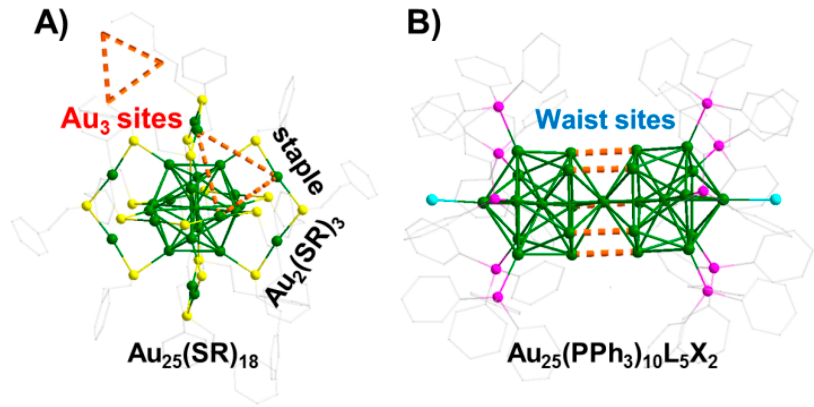
Figure 3. Framework of Au 25 (SR) 18 ( A ) and Au 25 (PPh 3 ) 10 L 5 Cl 2 ( B ). The orange areas in are the Au 3 and the waist active sites during the catalysis. Reproduced with permission from [36]. American Chemical Society, 2008 and Springer, 2019.